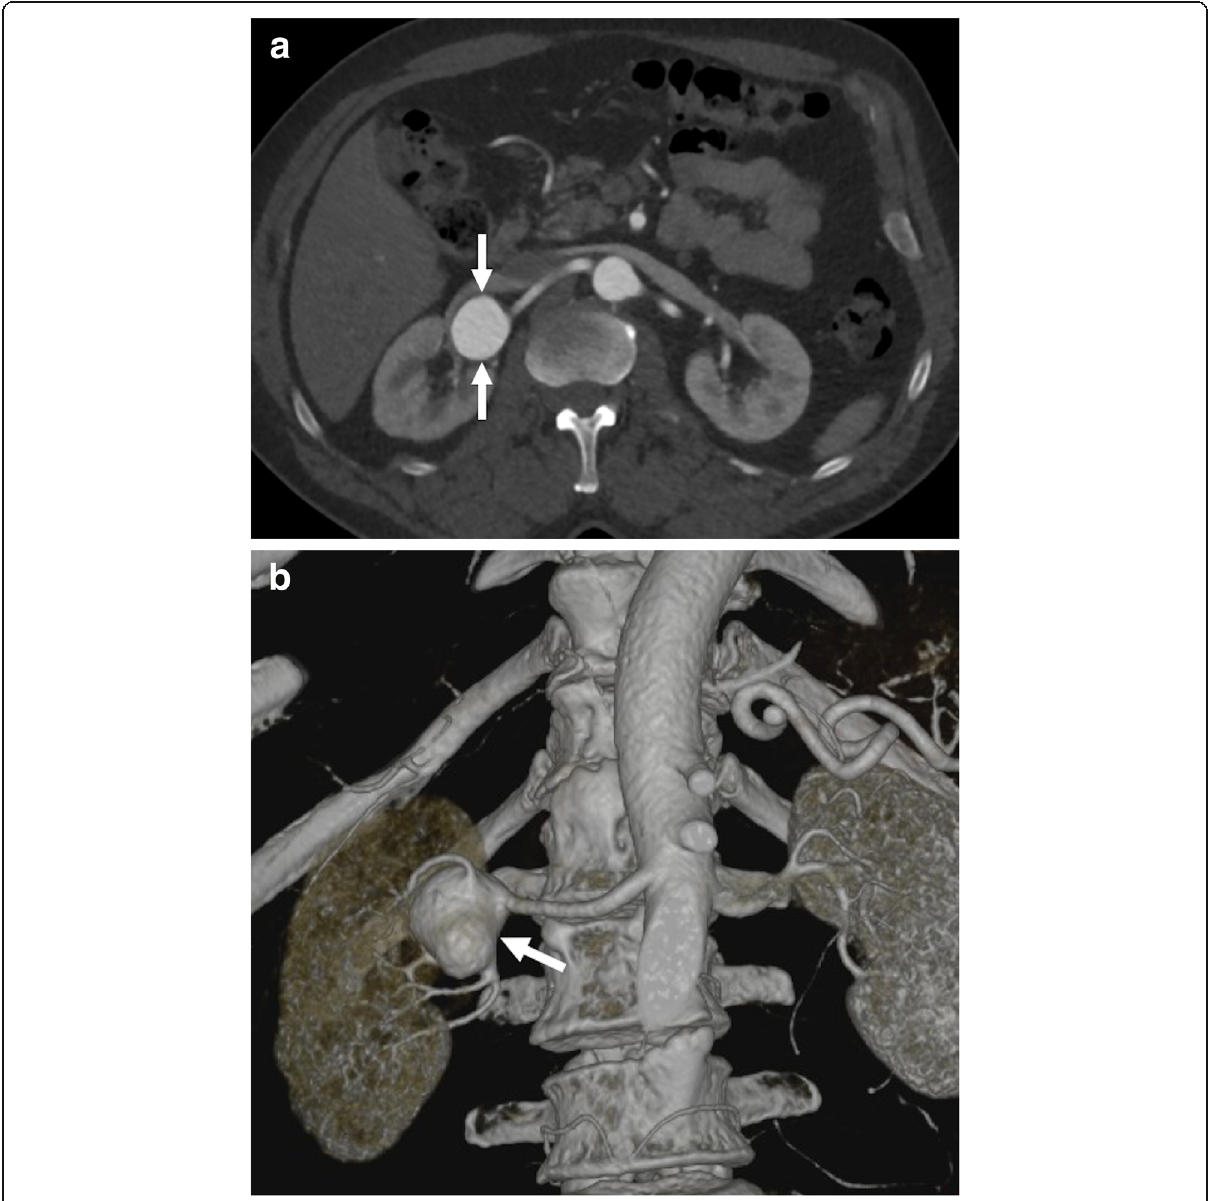
Fig. 13 Renal artery aneurysm. A 56-year-old male with no past medical history presented to ED with right flank pain. Preliminary US study showed a large cystic mass within the right renal hilum. a Axial arterial phase CT image shows a large renal artery aneurysm (arrows) with no evidence of rupture. b Reformatted volume-rendered image from the same study clearly demonstrates the aneurysm arising from the distal portion of the right renal artery (arrow). The patient was subsequently treated with elective